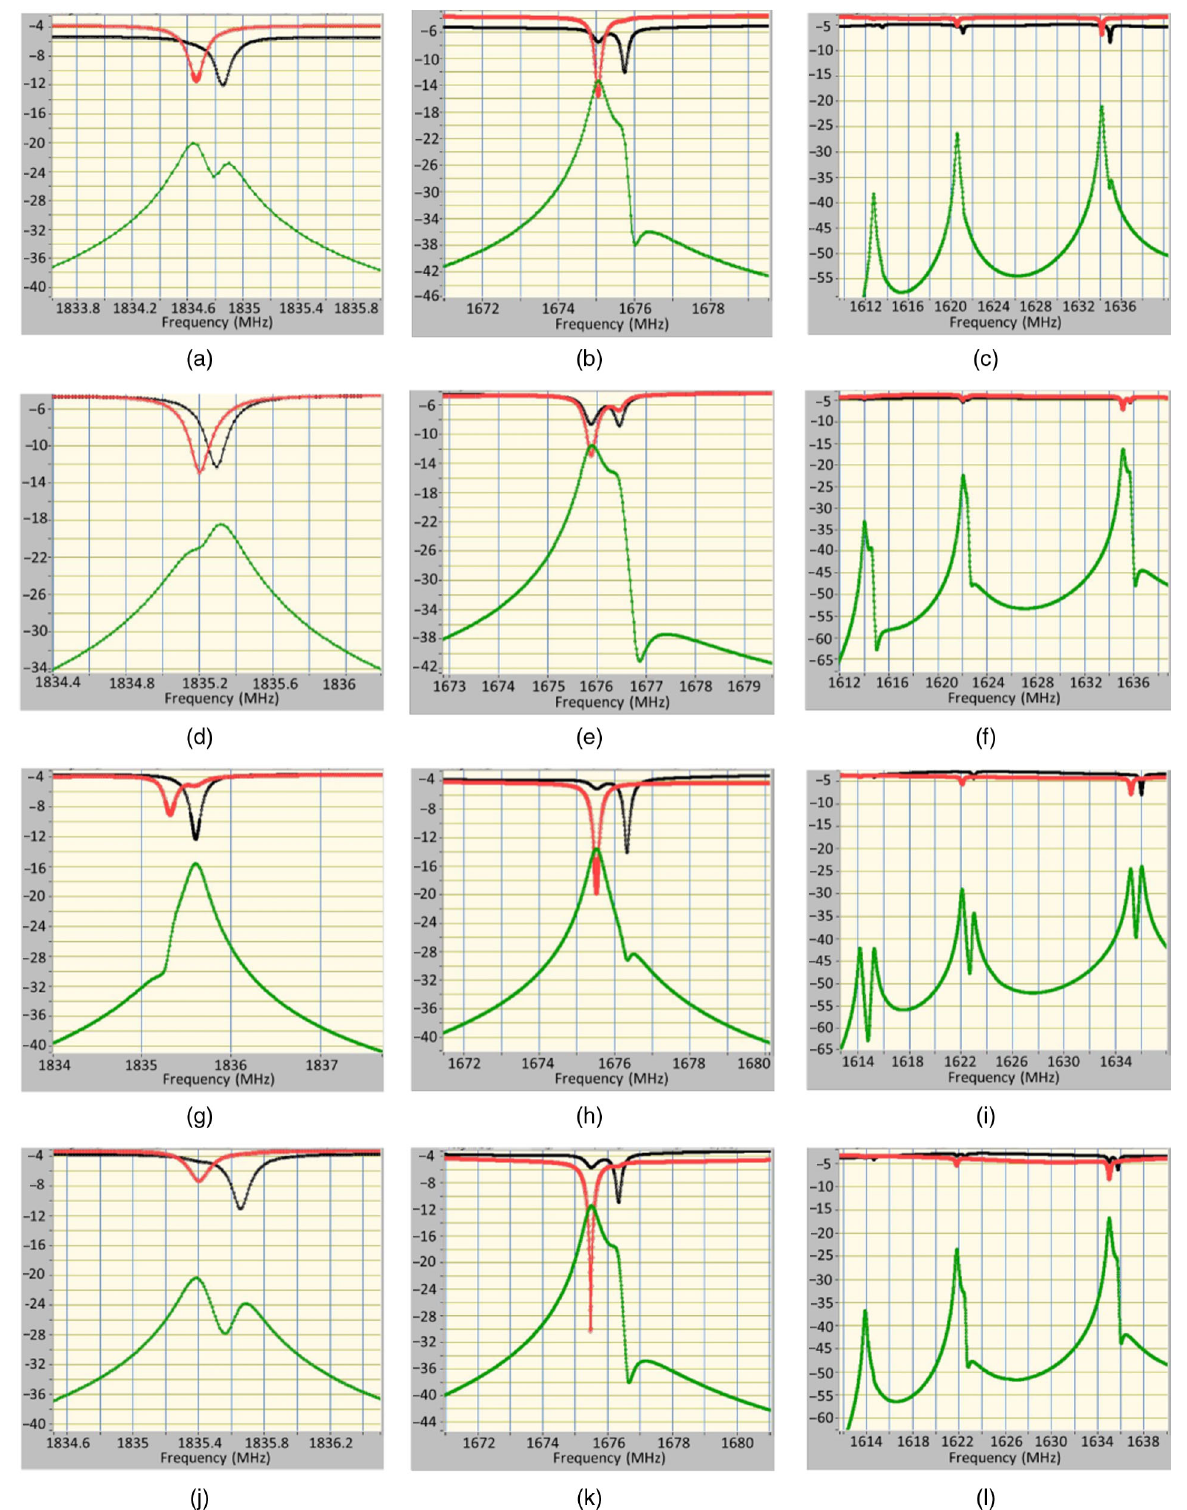
FIG. 9. Plots of the S 21 (green), S 11 (red), and S 22 (black) parameters for some of the dipole modes used for plasma processing. The parameters were measured on CAV1-4-5-8 from top to bottom using a network analyzer, the y axis is in the unit of dB. (a), (d), (g), and (j) contain the 2D-1 peaks, (b), (e), (h), and (k) show the 1D-5 peaks, and (c), (f), (i), and (l) show the 1D-1, 1D-2, and 1D-3 peaks. The plots present an example of the different couplings to the HOM and the dipole splitting characteristics of each cavity. Exact measurements of the S 21 , S 11 , and S 22 are critical, particularly for mode 2D-1, to correctly identify the rf frequency to use during plasma ignition in order to minimize the probability of causing plasma ignition at the HOM